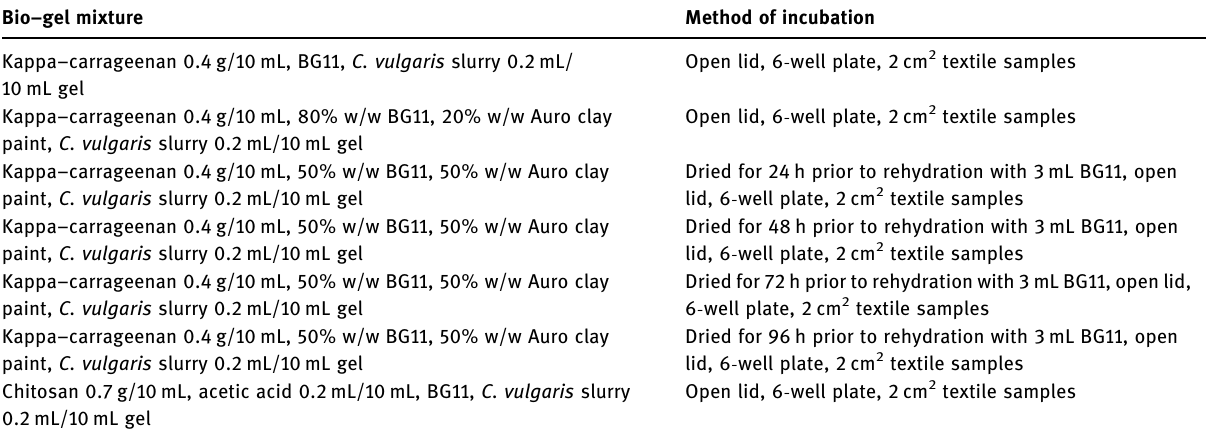
Table 3: Bio – gel mixtures within open setup and method of